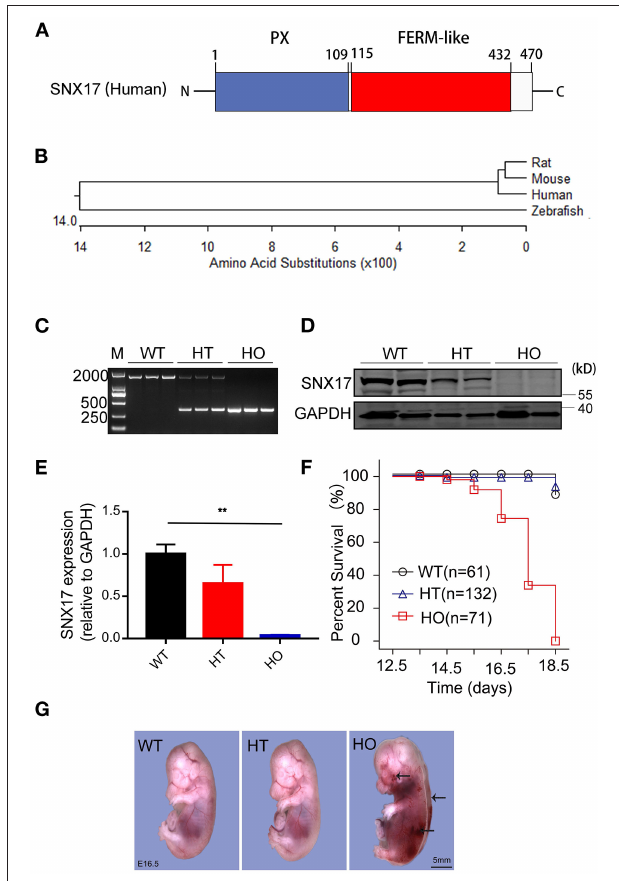
FIGURE 2 | Ablation of SNX17 causes embryonic death around mid-gestation in rats. (A) A schematic representation of the human SNX17 structure. (B) Phylogenetic tree showing the relationship among different organisms. (C) Genotyping of SNX17 knockouts. (D,E) Western blots showing levels of the SNX17 protein at E16.5 ( D , representative blots; E , pooled data). n = 3 samples per group. (F) Survival curve for embryos (E12.5–E18.5). A total of 264 embryos were genotyped. (G) Embryos at E16.5. Mutant embryo exhibited severe edema and hemorrhage (black arrow). M, DNA marker 2000; WT, wild-type; HT, heterozygous; HO, homozygous. ** p < 0.01.